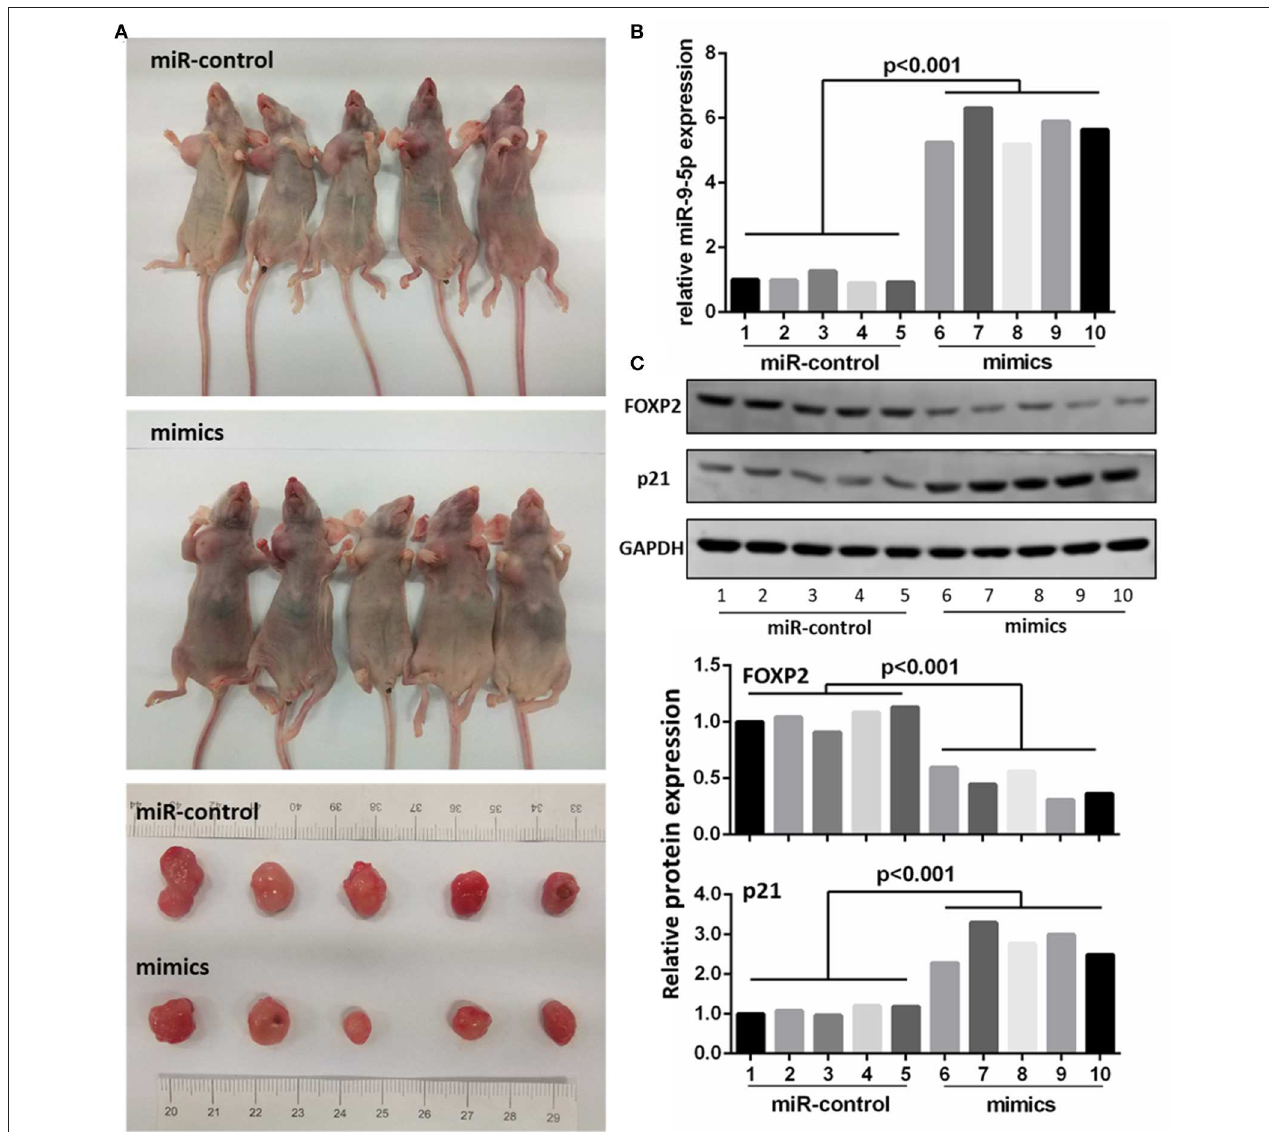
FIGURE 5 | MiR-9-5p inhibits tumor growth in vivo . (A) Mice injected with miR-9-5p mimics have smaller tumors compared with control group. (B) q-PCR shows that miR-9-5p expression of mimics group is extremely higher than that of control group ( p < 0.001). (C) Western blot shows that in mimics group, FOXP2 expression is lower ( p < 0.001) and p21 expression is higher ( p <